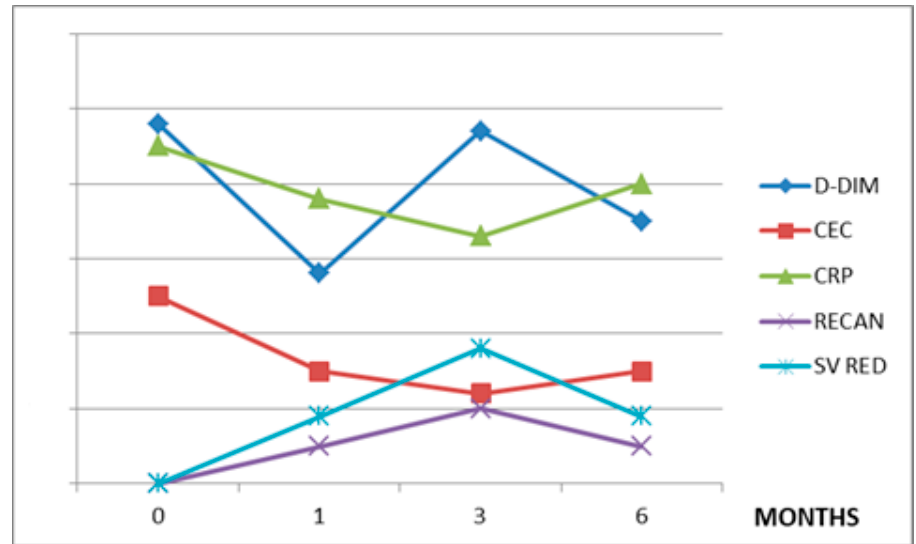
Figure 3. VKA (C) group. CEC: circulating endothelial cells, CRP: C-reactive protein, D-DIM: d- dimers, RECAN: % of recanalization, SV: % of splenic volume reduction. Values on y-axis are in arbitrary measures.